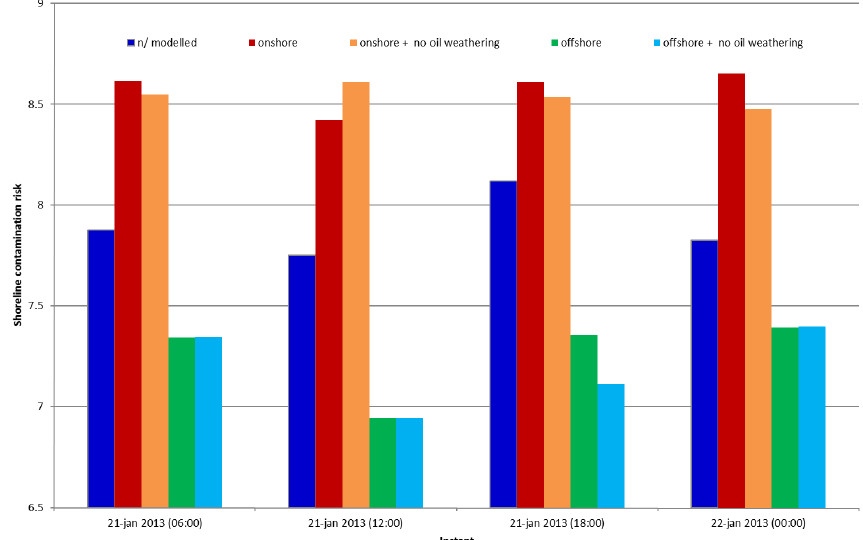
Figure 15. Integrated shoreline contamination risk levels at different time instants from 21 and 22 January 2013. Results presented as mean values for the shoreline in the whole pilot area studied. Shoreline risk levels computed with four different approaches: non-modelled approach; modelled approach using onshore wind; modelled approach without oil weathering processes, using onshore wind; modelled approach using offshore wind; modelled approach without oil weathering processes, using offshore